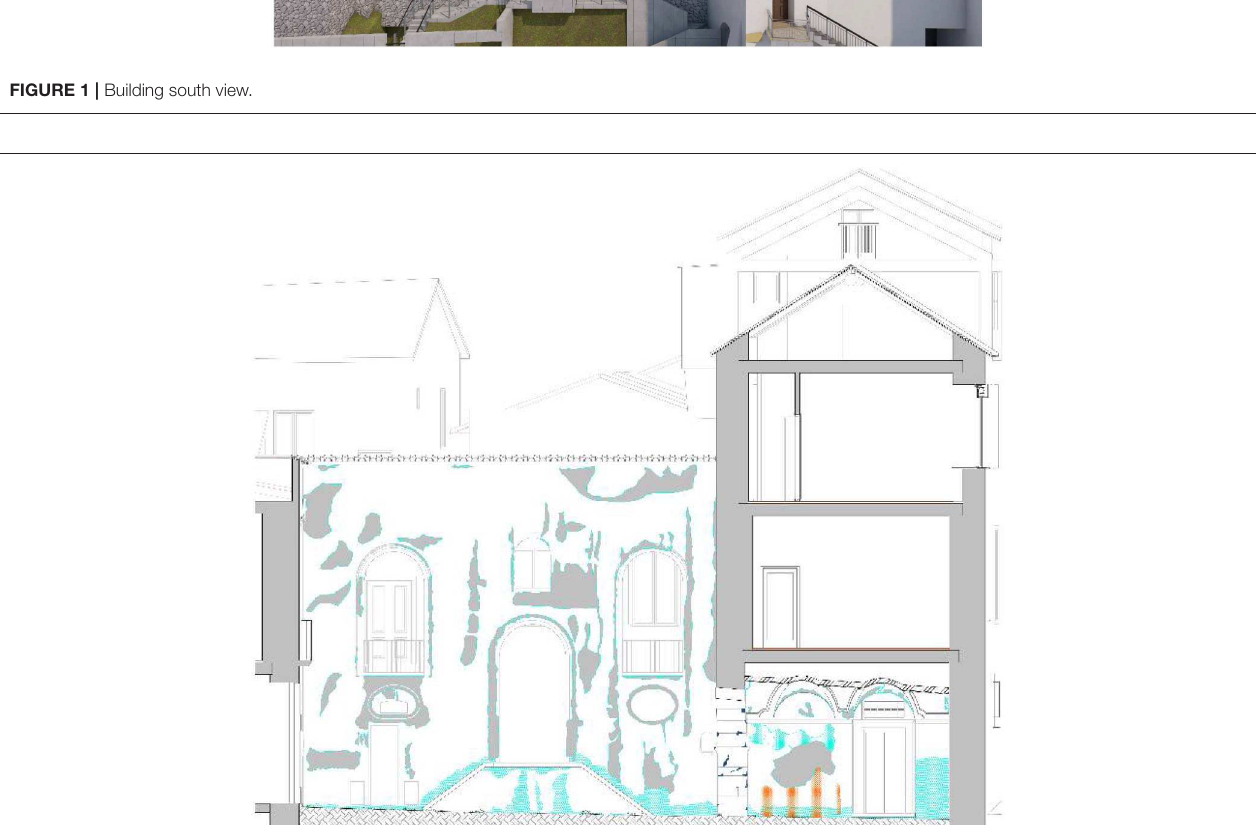
FIGURE 2 | Degradation analysis